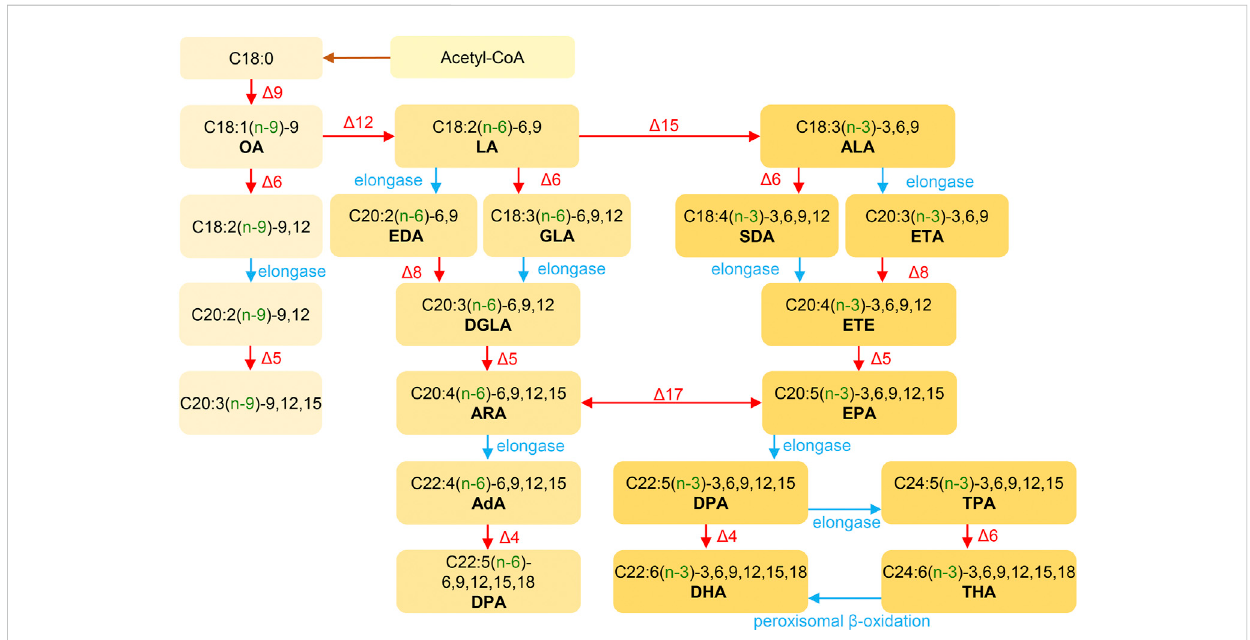
FIGURE 4 The general pathways of PUFAs synthesis. Desaturase: Δ 4/ Δ 5/ Δ 6/ Δ 9/ Δ 15/ Δ 17; C18/20/22, carbon numbers; :1/:2/ ... /:6, number of ole fi nic bonds; (n-3/6/9), double bond between the (n – x) and (n-x+1) to last carbon atoms; − 3/6/9/12/15/18, double bond between the x and x+1 to last carbon atoms. AdA, adrenic acid; ALA, α -linolenic acid; ARA, arachidonic acid; DGLA, dihomo- γ -linolenic acid; DHA, docosahexaenoic acid; DPA, osbond acid; DPA, Docosapentaenoicacid;EDA,eicosadienoicacid;EPA,eicosapentaenoicacid;ETA,eicosatrienoicacid;ETE,eicosatetraenoicacid;GLA, γ -linolenic acid; LA, linoleic acid; OA, oleic acid; SDA, stearidonic acid; THA, tetracosahexanoic acid; TPA, tetracosapentanoic